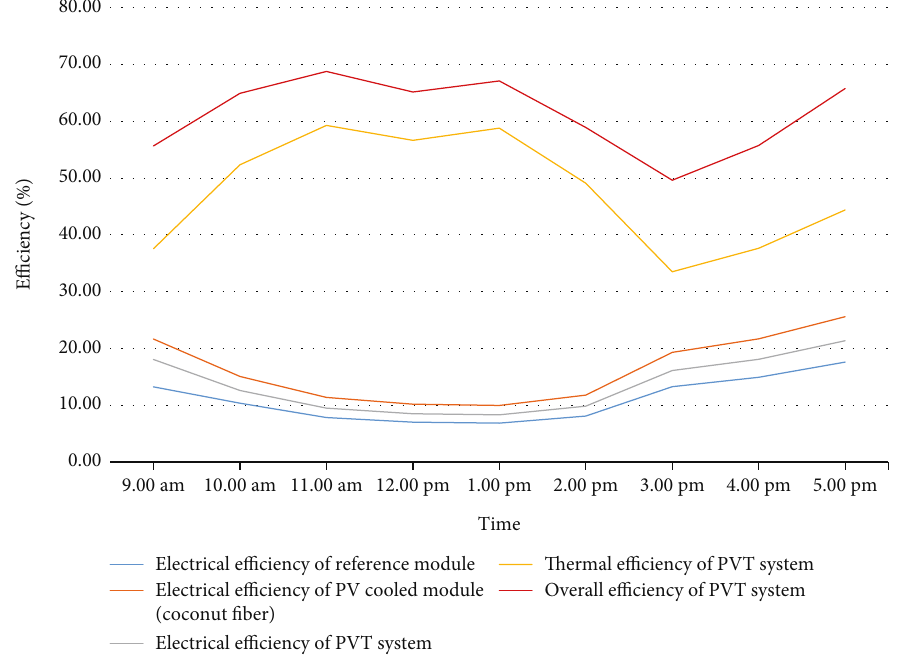
Figure 7: Comparison of electrical, thermal, and overall e ffi ciency of uncooled, cooled, and PVT